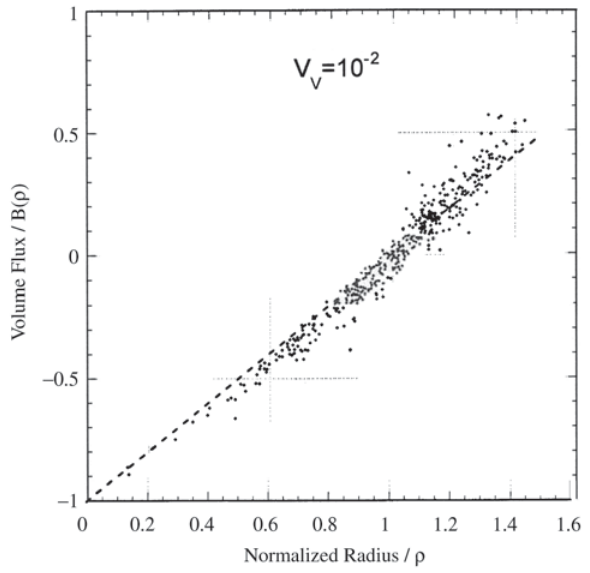
Figure 5. Volume flux per steradian, B( ρ ), versus scaled particle radius, ρ . Data are simulated from the multiparticle diffusion model for a microstructure with a dispersoid volume fraction V The associated microstructural noise distribution for these fluxes is shown by the scatter of the simulation data relative to the noise- free linear flux function (dashed line) predicted from LSW theory. Even at this small (but non-zero ) volume fraction, discernible fluc- tuations, or “locale noise”, are evident.